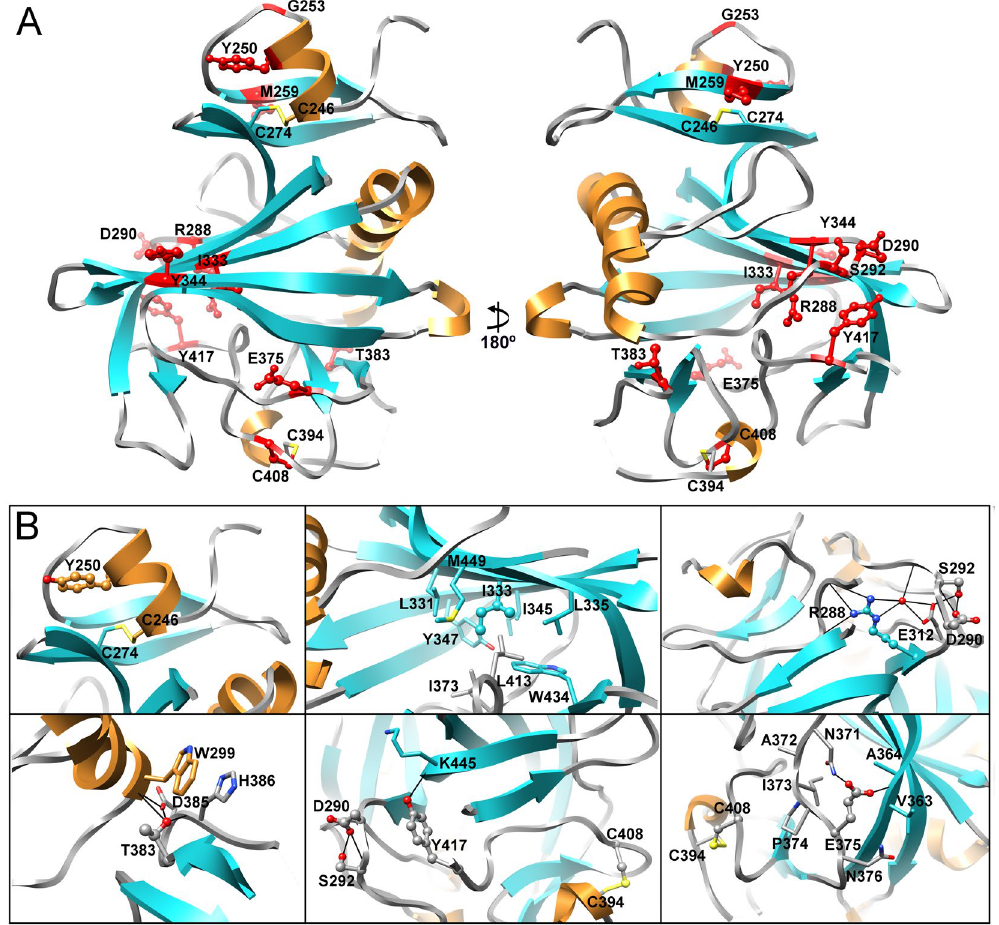
Figure 3. Structural analysis of mutations in Angptl3 which cause loss of function. ( A ) Angptl3 fibrinogen-like domain crystal structure with the sites of loss of function mutations depicted in ball and stick representation and highlighted in red. ( B ) Close up views of the environment of the mutated amino acids in panel A. Mutated residues are shown in ball and stick representation and neighboring or interacting residues are in stick representation. Residues are colored according to their location in the secondary structure elements with nitrogen atoms in blue, oxygen in red and sulfur in yellow. Potential hydrogen bonds are depicted as solid black